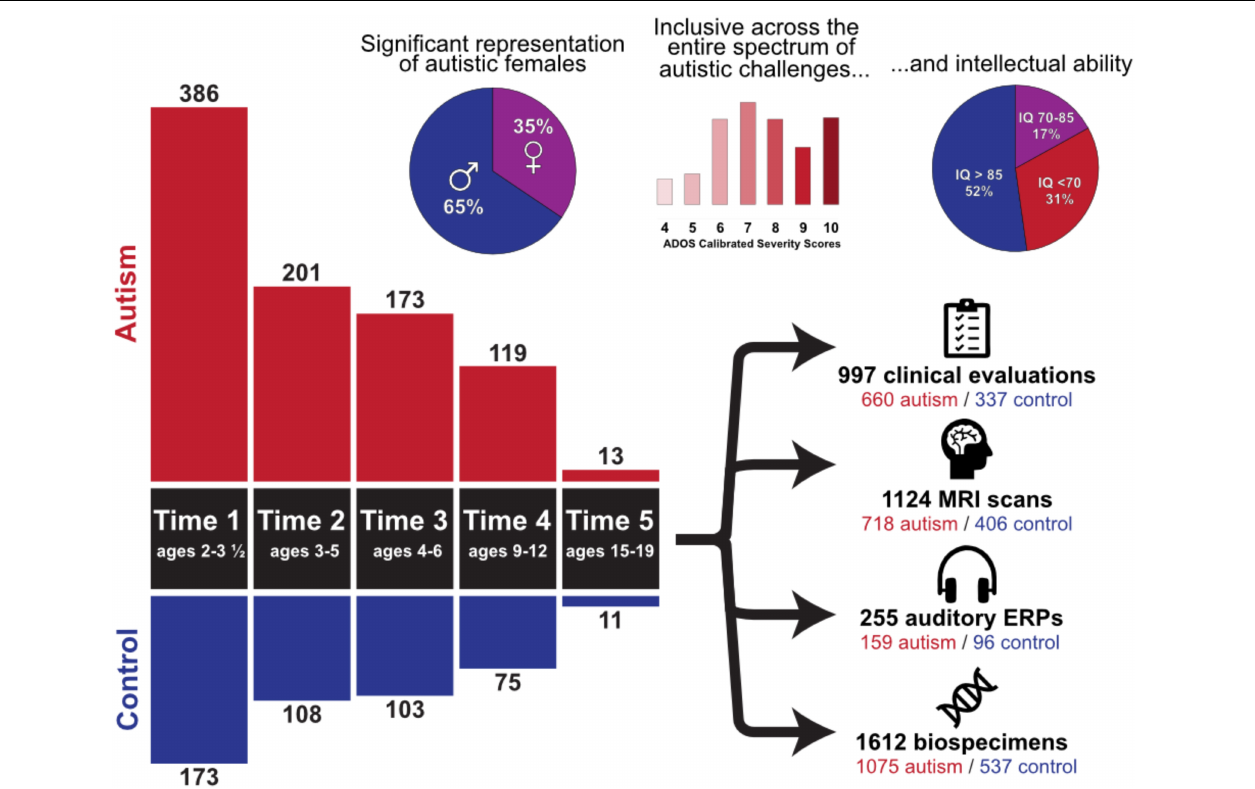
FIGURE 1 | Overview of the Autism Phenome Project cohort. Longitudinal behavioral, neuroimaging, and medical data has been acquired since 2006 in over 500 children from early childhood through adolescence. The cohort includes children across the entire autism spectrum, including understudied groups such as females and children with co-occurring intellectual disability. Data collection at all-time points is ongoing. ADOS Calibrated Severity Scores at Time 1 and IQ scores at Time 4 are